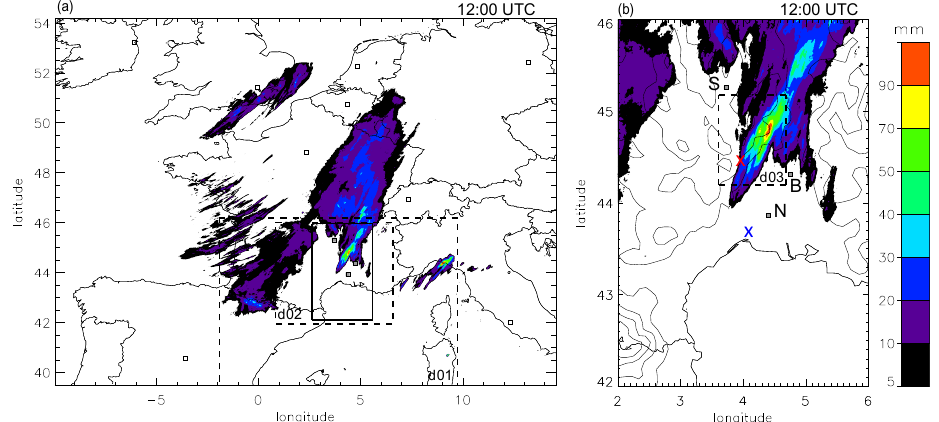
Figure 1. 12-h cumulative rainfall retrieved from the French radars network ARAMIS: ( a ) over France and ( b ) over the Cévennes-Vivarais region. The rectangles present the area of the Cévennes-Vivarais region (solid), which corresponds to region presented in the panel ( b ), and the domains d01, d02 and d03 (dashed) used in the different simulations. Note that the innermost domain (d03) is presented in panel ( b ). The S- and C-band operational radars (Bollène, Nimes and Sembadel) covering the innermost domain (d03) of the simulations are represented by the grey small filled squares (in panels ( a ) and ( b ) and by letters B, N and S (in panel ( b ). The red and blue crosses show respectively the position of the X-band radar of the LaMP ( Laboratoire de Météorologie Physique ) and the UHF radar of the CNRM ( Centre National de Recherches Météorologiques - Météo-France ) located at Candillargues. The sounding used in this study was launched from the Nimes station represented by the letter N in panel ( b ). The topography is represented in the panel ( b ) from sea level to 2000 m height every 400